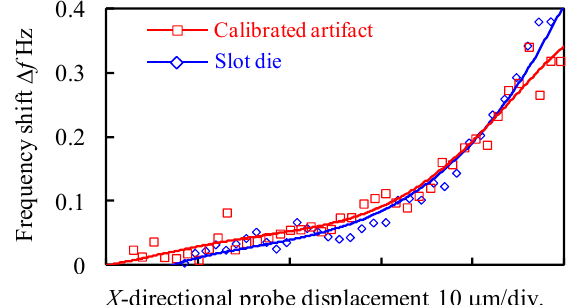
Figure 4. Vibration frequency shifts when probing the calibrated artifact and the slot die.